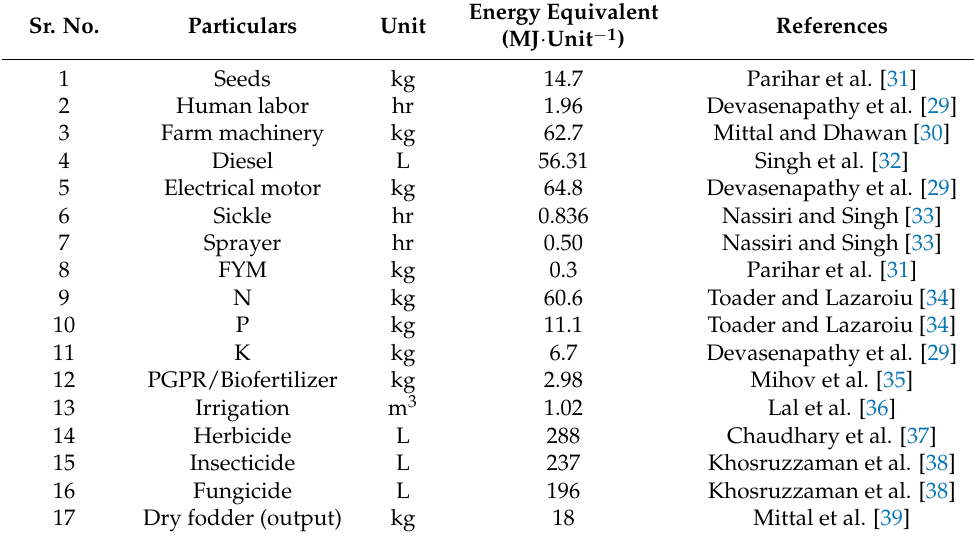
Table 2. Energy equivalents of inputs and output used for fodder maize cultivation. Sr.